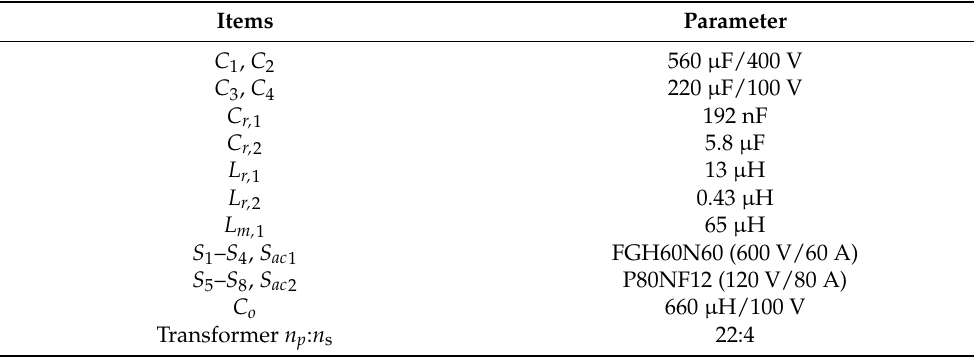
Table 1. Circuit parameters used in the prototype circuit.